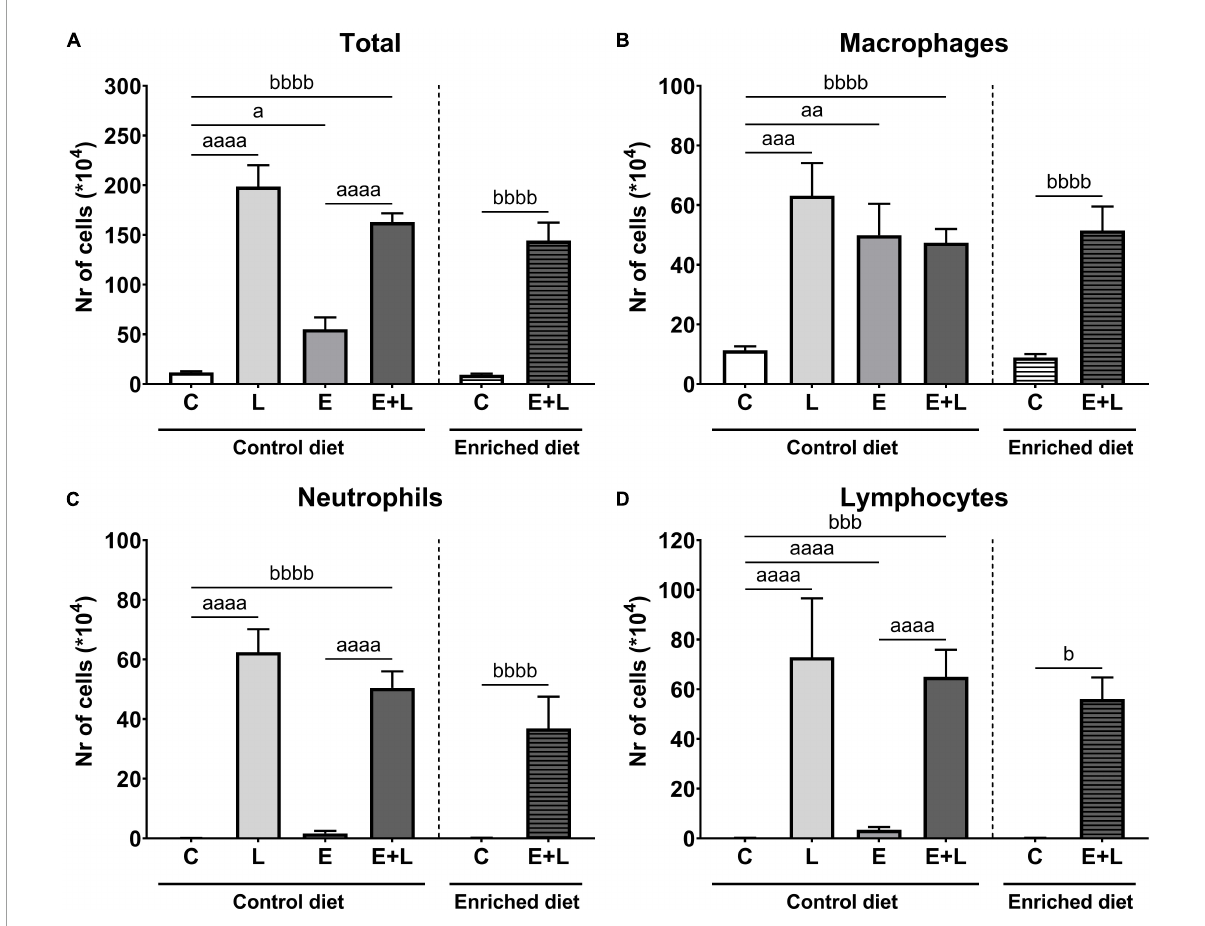
FIGURE3 Number of inflammatory cells in BAL at the end of the experiment, 10 days after the last LPS exposure. The total number of cells (A) has been determined first. Using this number together with differential cell counts, the number of macrophages (B) , neutrophils (C) , and lymphocytes (D) was determined. a p < 0.05; aa p < 0.01; aaa p < 0.001; aaaa p < 0.0001 (first analysis for elastase and/or LPS effects). b p < 0.05; bbb p < 0.001; bbbb p < 0.0001 (second analysis for diet and/or E + L effects). Data are presented as mean ± SEM. C = control (control diet: n = 7; enriched diet: n = 6); L = LPS ( n = 6); E = elastase ( n = 8); E + L = elastase plus LPS (control diet: n = 9; enriched diet: n =